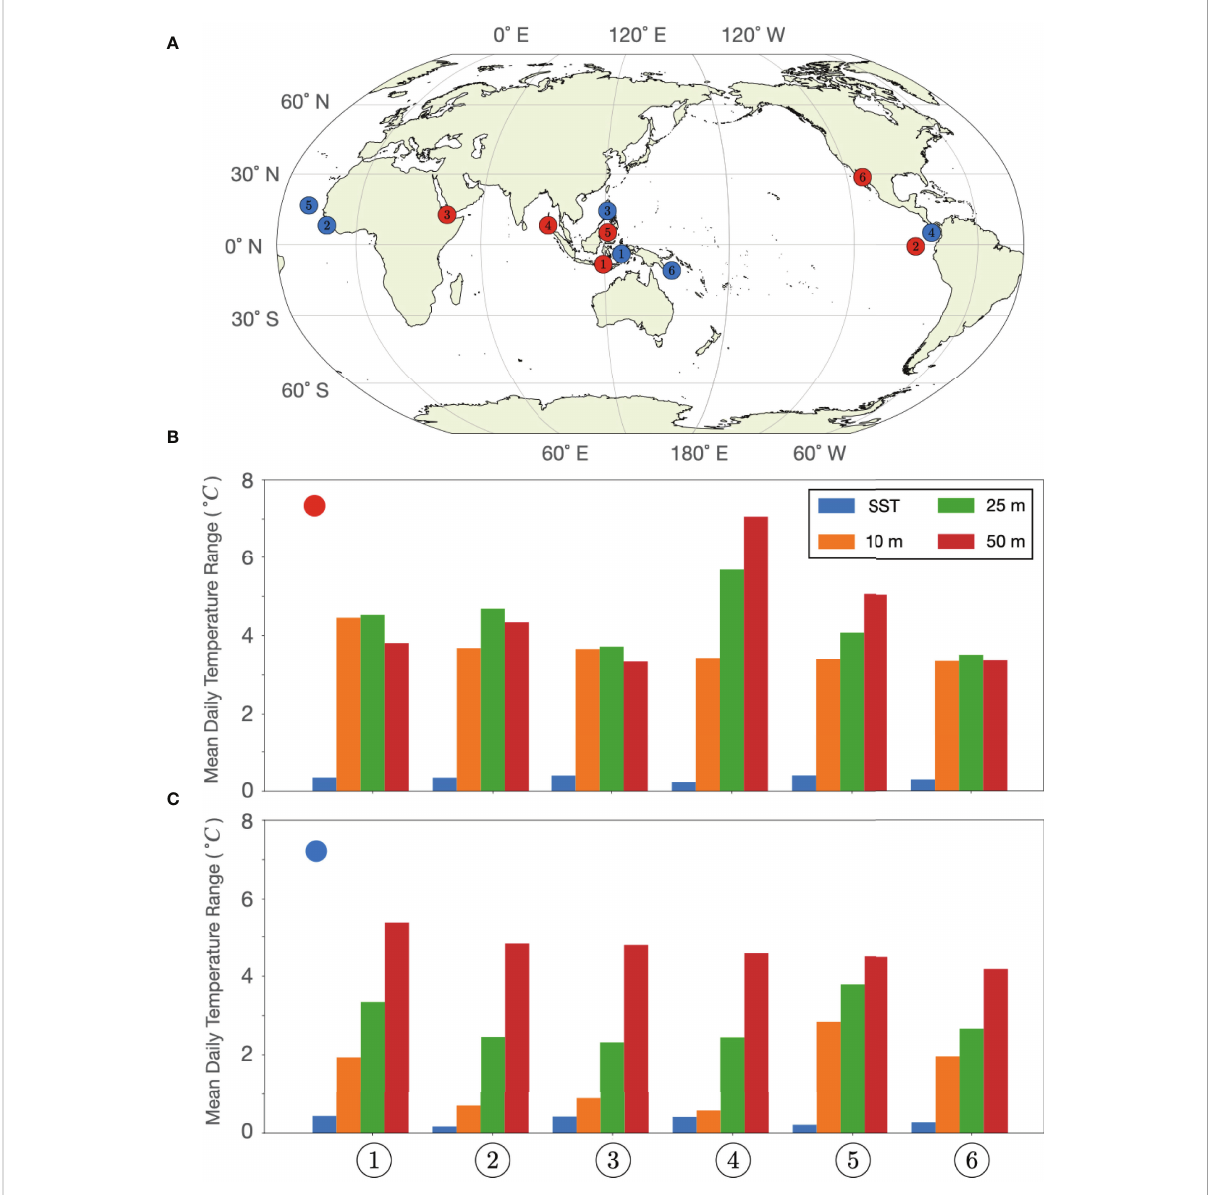
FIGURE 6 (A) Locations with largest mean daily temperature range at 10 m (red) and 50 m (blue) depths. Temperature ranges at the sea surface, 10 m, 25 m, and 50 m are shown for the red locations in (B) and blue locations in (C) . Red: ① : Sape Strait, 8.56° S 119.23° E, ② : Galápagos Islands, 0.96°